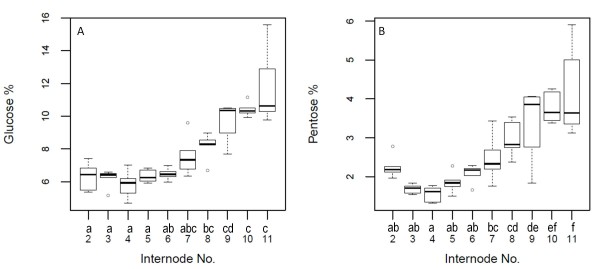
Box-plots of across internode variability for glucose (A) and pentose (B) yield. Cell wall glucose and pentose yield (%) were measured from the second to the eleventh main stalk internodes above-ground. A total of five plants from maize inbred line B73 grown in the glasshouse were measured for each internode. Letters above the internodes numbers (x-axis) corresponds to the mean comparisons adjusted for multiple testing with Bonferroni method. Internodes that share a letter are not significantly different at p = 0.05.